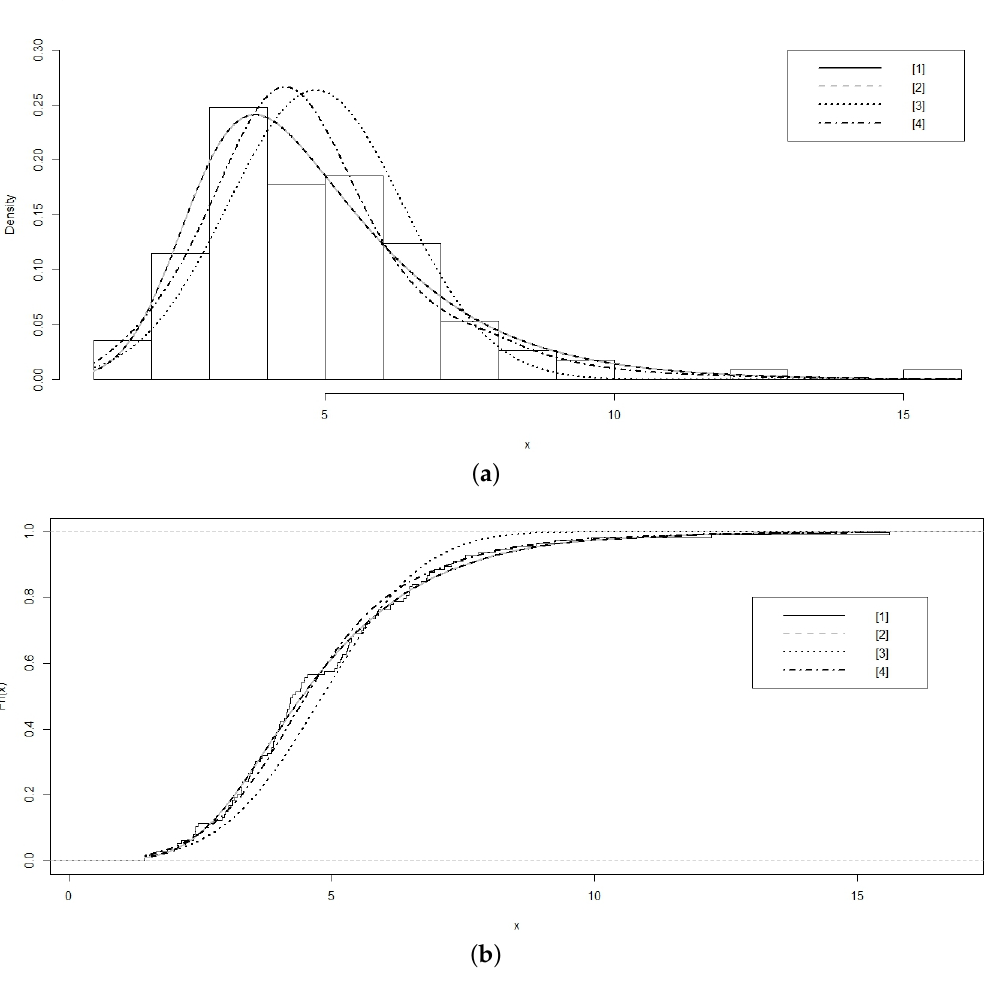
Figure 5. Education data - Fitted distributions. [1] Skew GL-Normal distribution; [2] Skew GL- t distribution; [3] Skew Normal-GL distribution; [4] Skew t -GL distribution. ( a ) Probability density function; ( b ) Cumulative